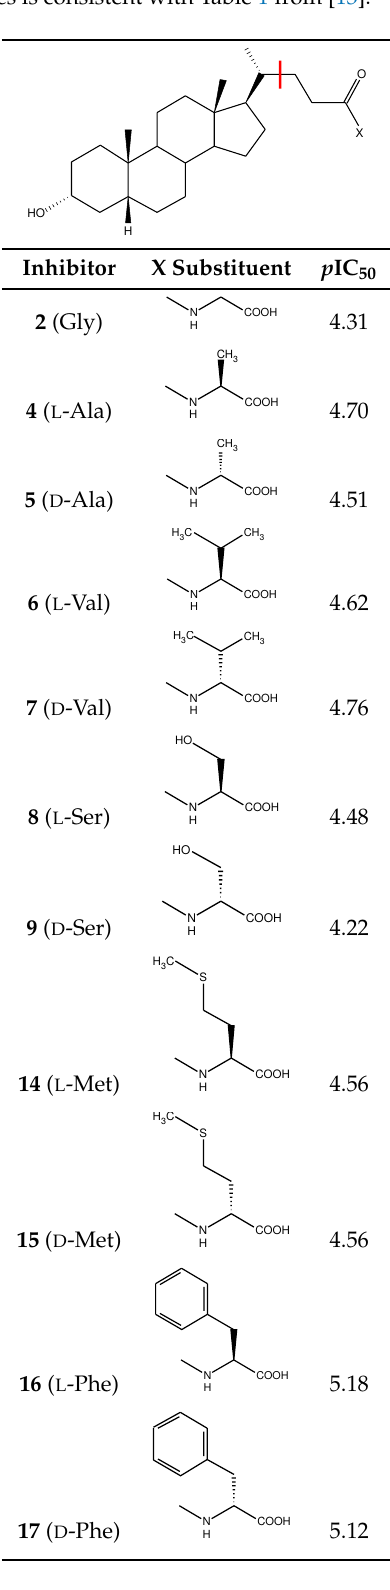
Table 1. The structures and experimental activity a of inhibitors targeting EphA2-ephrin A1 interaction. The numbering of the structures is consistent with Table 1 from